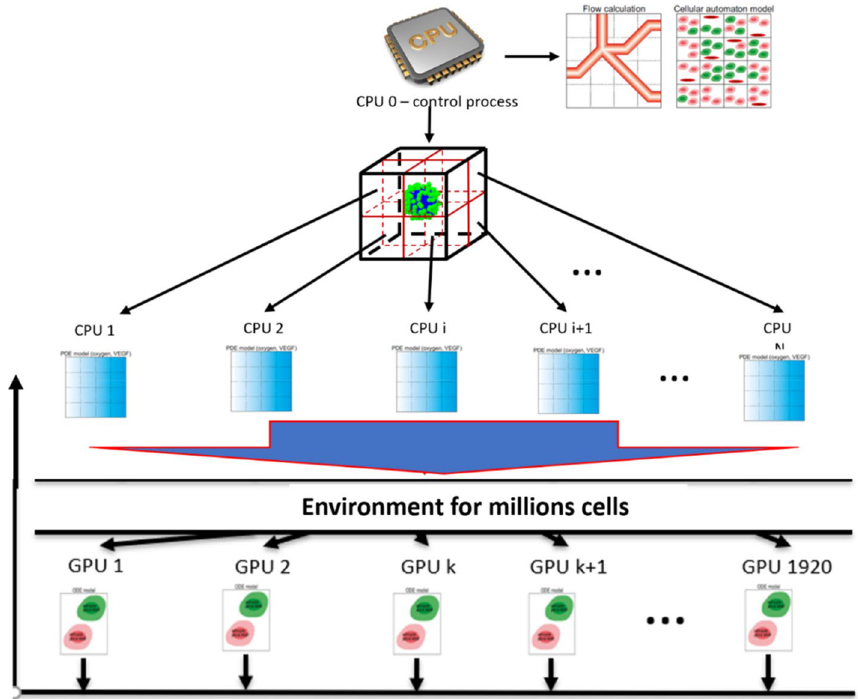
Figure 3. CPU-GPU systems for simulation. Strategy with parallelized CPU-GPU systems for simulation of the hybrid multiscale models for vascularized tumour growth. The extracellular concentrations (glucose/oxygen) are used to update the intracellular network and therefore the synchronization of both models takes place after the update of diffusible